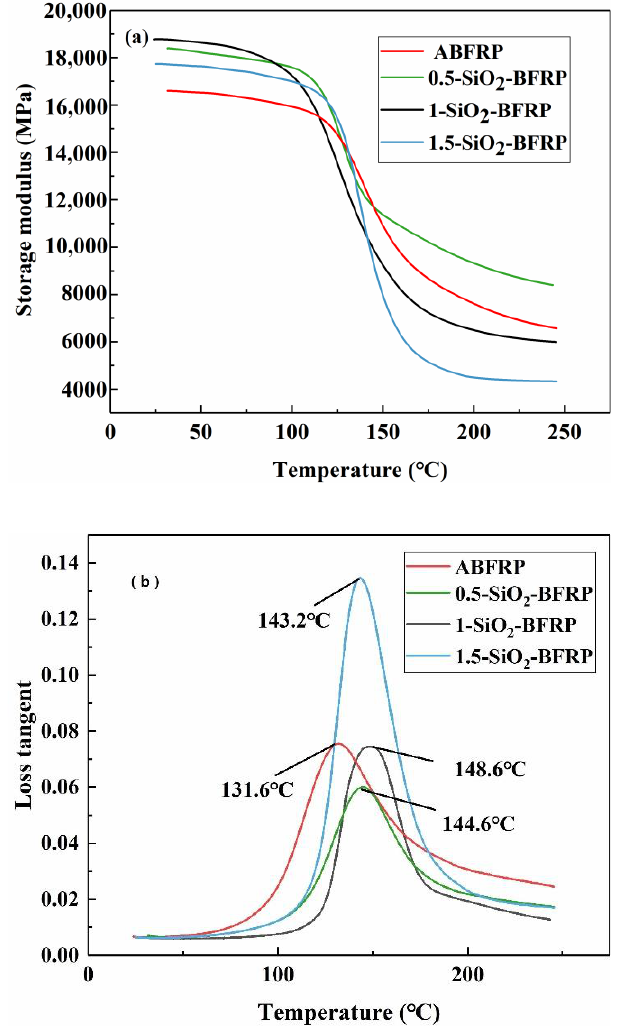
Figure 12. DMA experimental results of composites treated with SiO 2 –COOH at different concentra- tions: ( a ) Storage modulus–temperature curve; ( b ) loss tangent–temperature curve. TGA